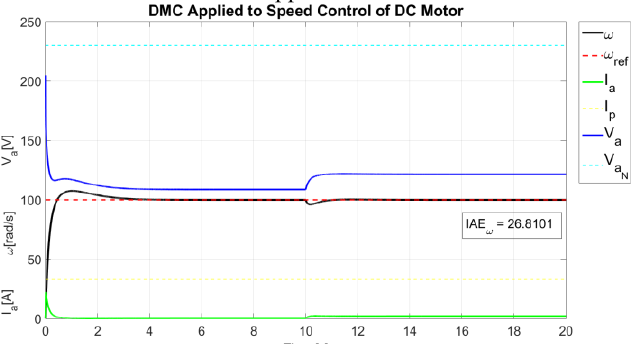
Figure 4. DC motor controlled by DMC tuned by deterministic method (ωref =100